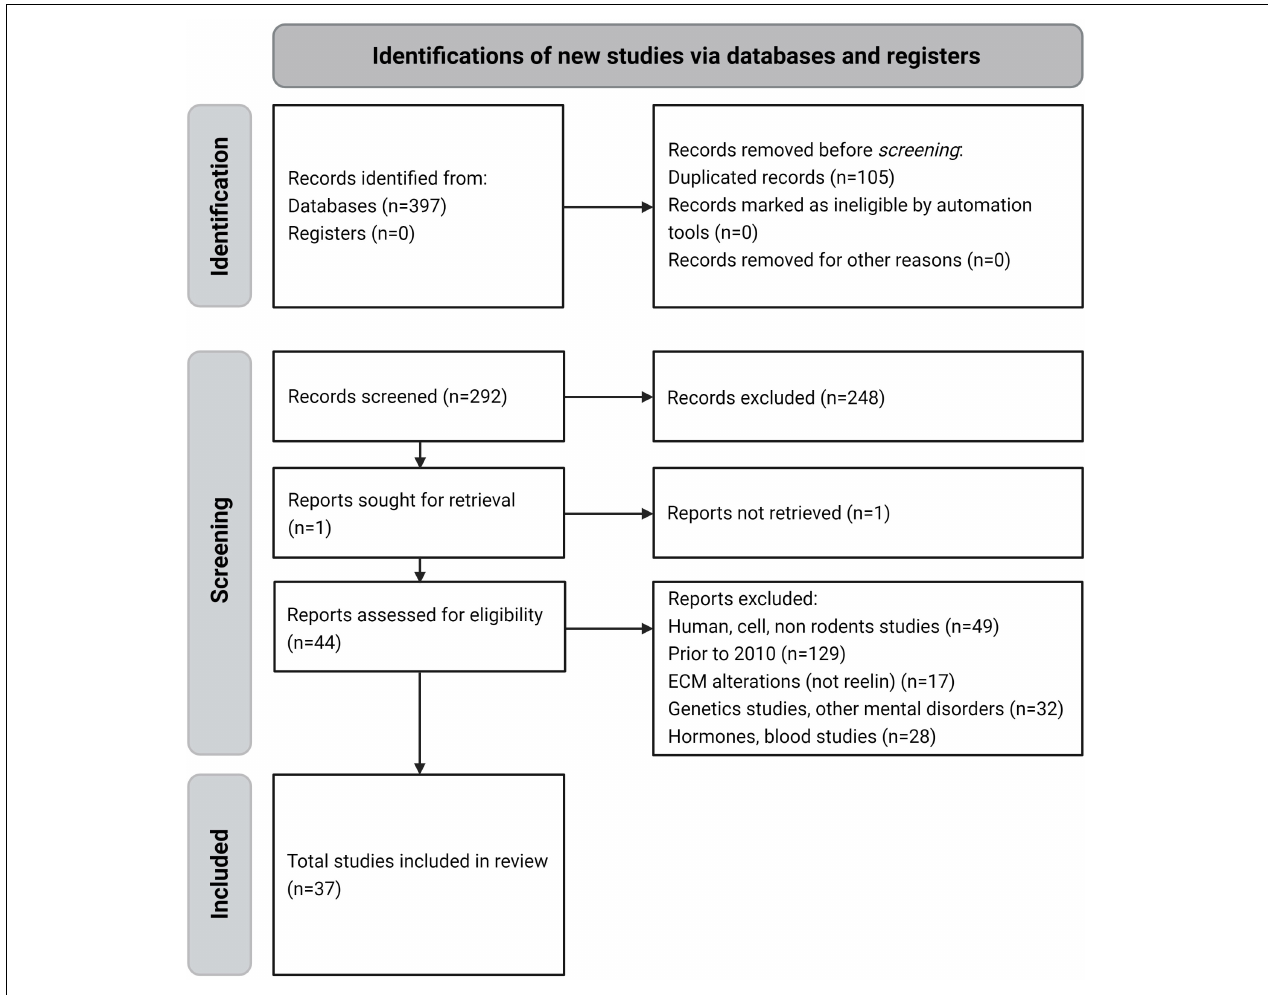
FIGURE 2 | PRISMA flow diagram of the reviewing process – systematic selection for inclusion or